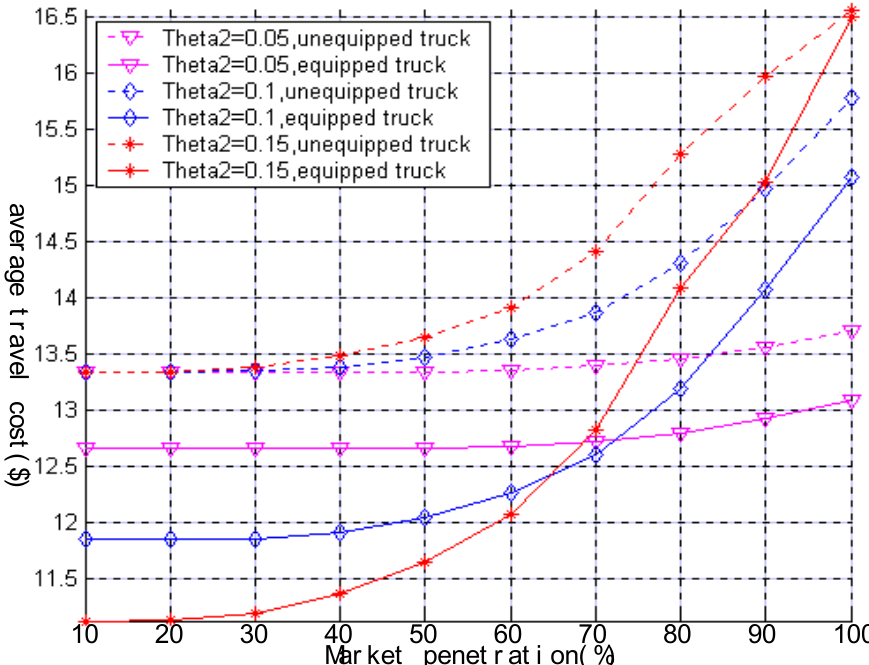
Figure 11. Average travel cost of truck with respect to market